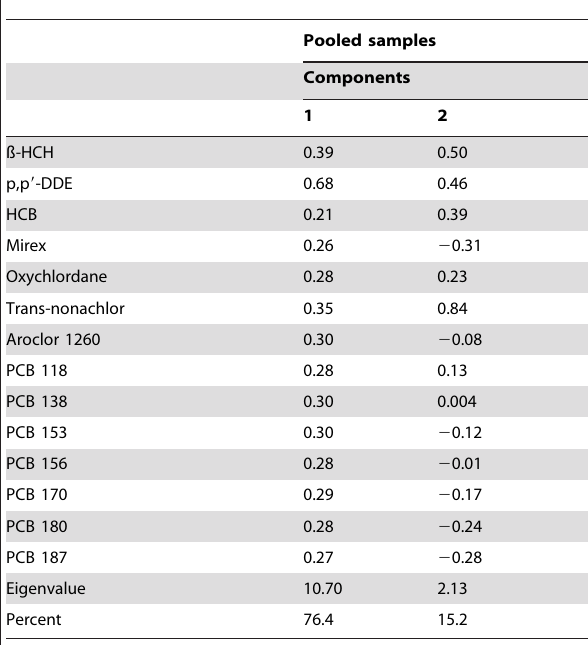
Table 2. Eigenvectors from principal component analysis of plasma persistent organic pollutant levels of pooled Caucasians and First Nations